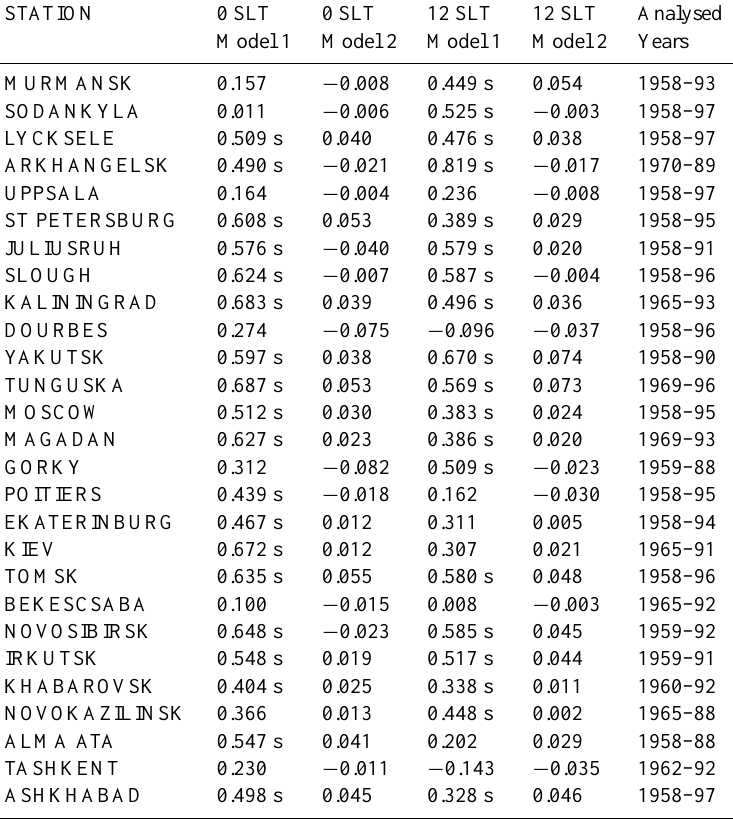
Table 6. Calculated coefficients of correlation r between annual mean hm F2 and Ap 12 values for the whole period with hm F2 observations available on a particular ionosonde station. Regression of hm F2 with R 12 (Model 1) and with R 12 + Ap 12 (Model 2), and all years in the indicated period are used to obtain the coefficients. Significant coefficients at a confidence level of 95% are denoted by “s” after the